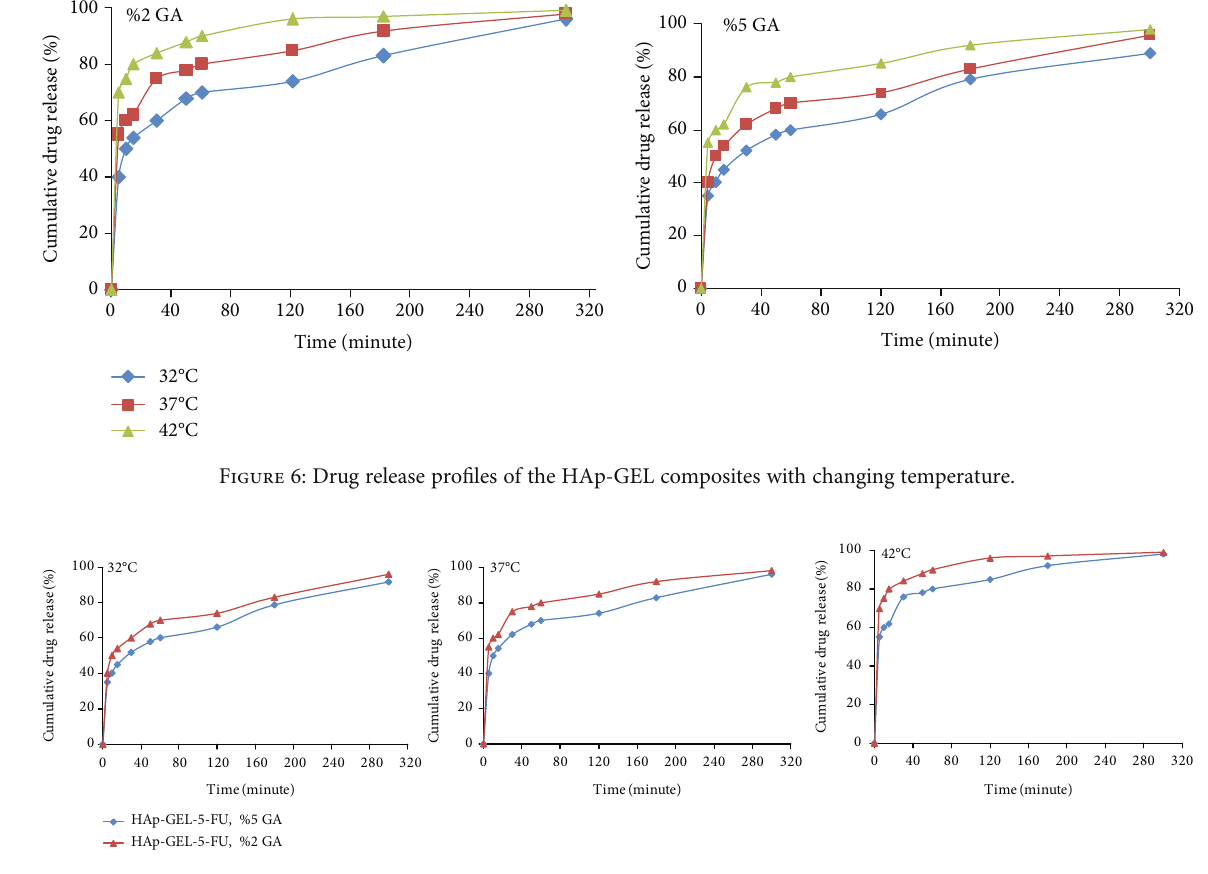
Figure 7: Drug release pro fi les of the HAp-GEL composites with changing GA values at 32 ° C, 37 ° C, and 42 ° C. Table 2: Kinetic parameters ( R 2 , K